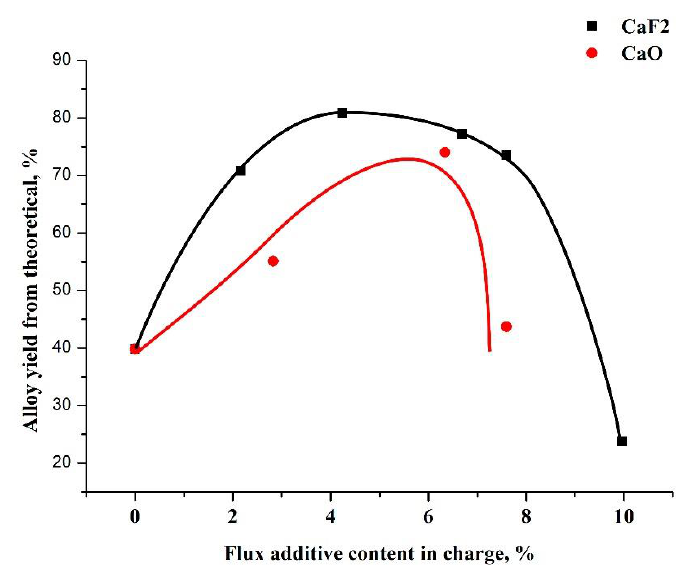
Figure 3. Plots of the influence of the amount of flux on the yield of the alloy.